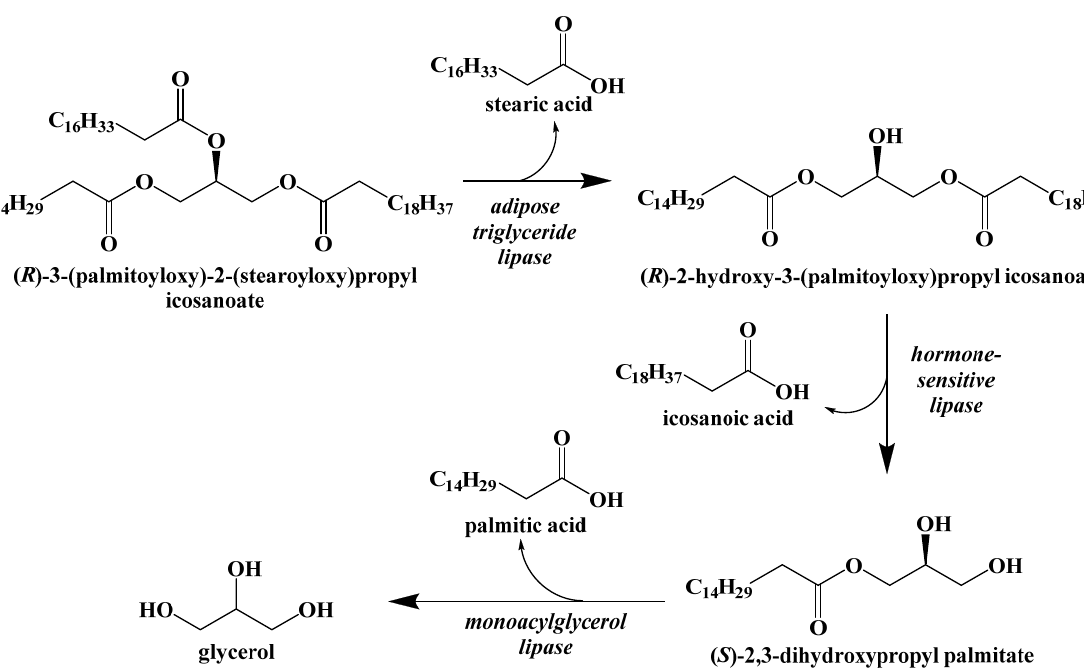
Figure 9. Lipolysis of Stored Triacylglycerides.